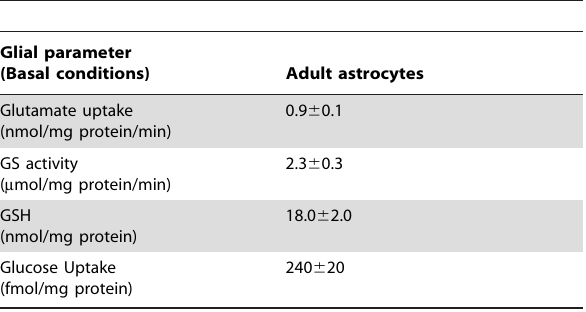
Table 1. Analysis of the main glial parameters in adult astrocytes under basal conditions.